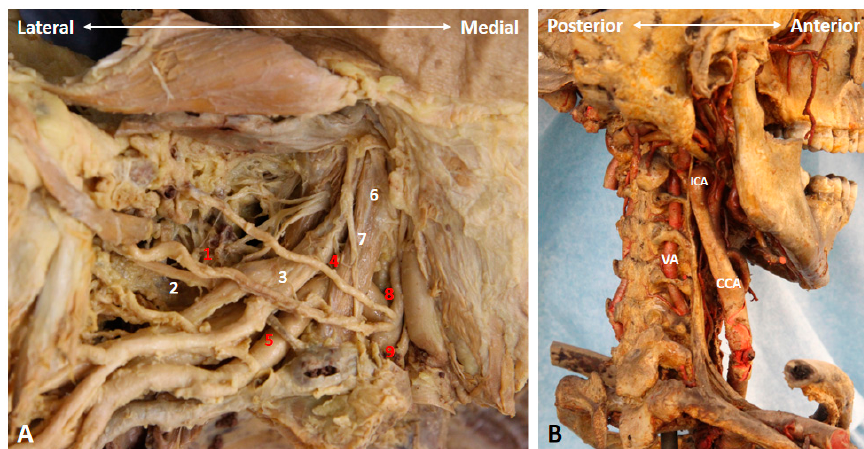
Figure 6. The transverse cervical artery, thyrocervical trunk, suprascapular artery and nerve ( A ), as well as the course and relevant vasculature of the vertebral artery ( B ) in a cadaver model. 1: suprascapular artery; 2: suprascapular nerve; 3: superior trunk; 4: transverse cervical artery; 5: subclavian artery; 6: anterior scalene muscle; 7: phrenic nerve; 8: inferior thyroid artery; 9: thyrocervical trunk. CCA: common carotid artery; ICA: internal carotid artery; VA: vertebral artery. Red numbers indicate arteries, while the white numbers indicate nerves and muscles.